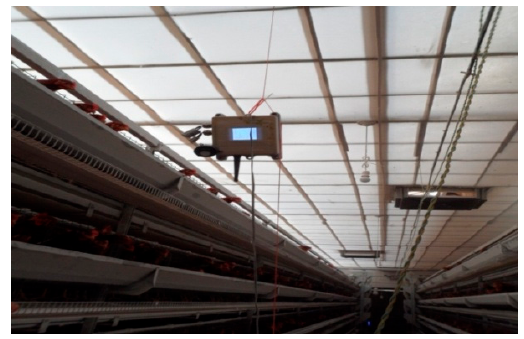
Figure 3. Experimentation in a closed poultry house.